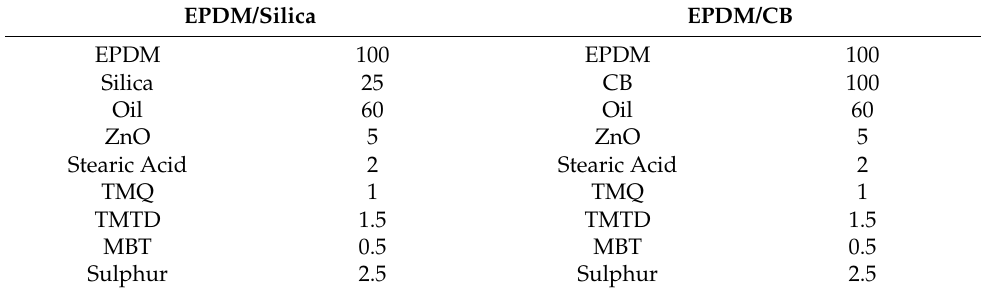
Table 2. Rubber compound recipes